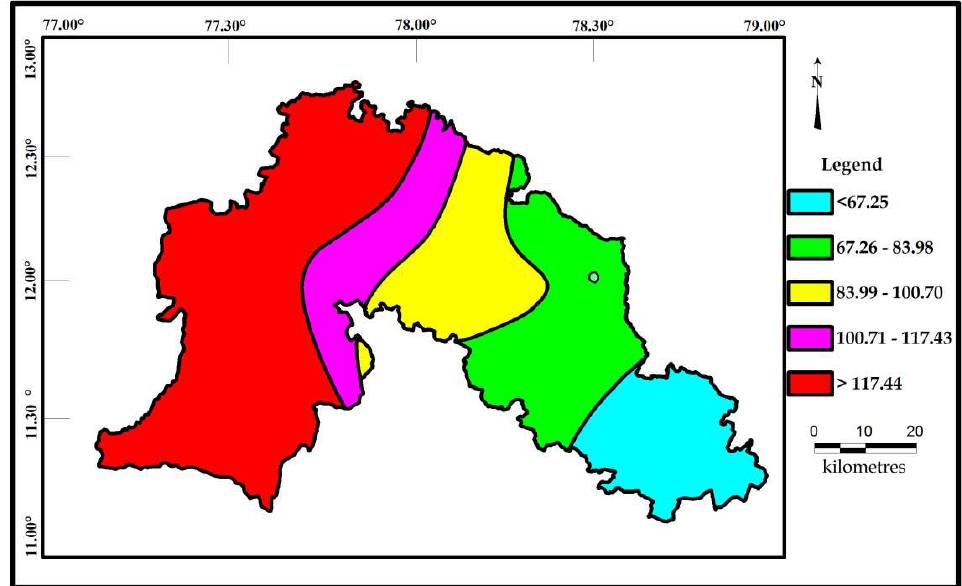
Figure 6. Spatial distribution of C d for the samples collected in the study area.